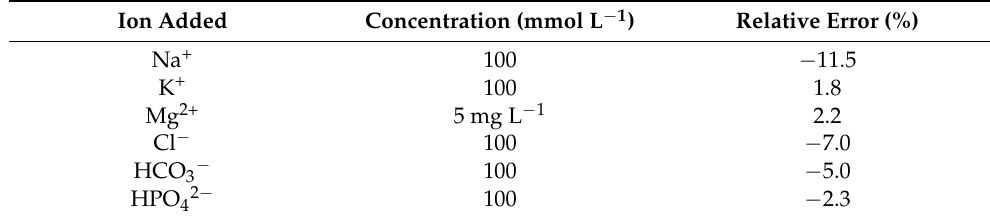
Table 1. Effect of various ions on the determination of calcium (20 mg L − 1 ) under the optimum experimental conditions.